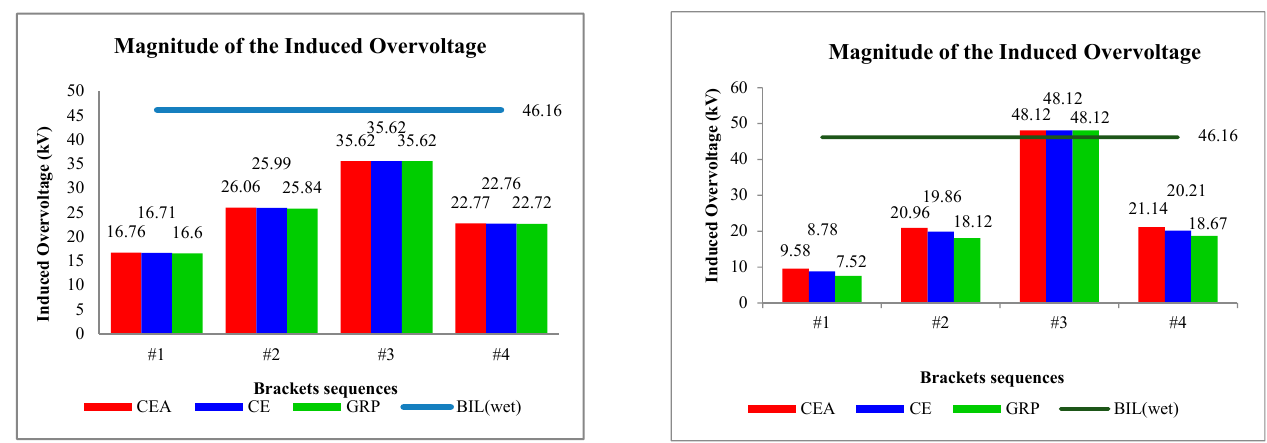
Figure 9. Induced overvoltage magnitude on the insulated rail brackets for both 30 kA ( left ) and 90 kA ( right ).